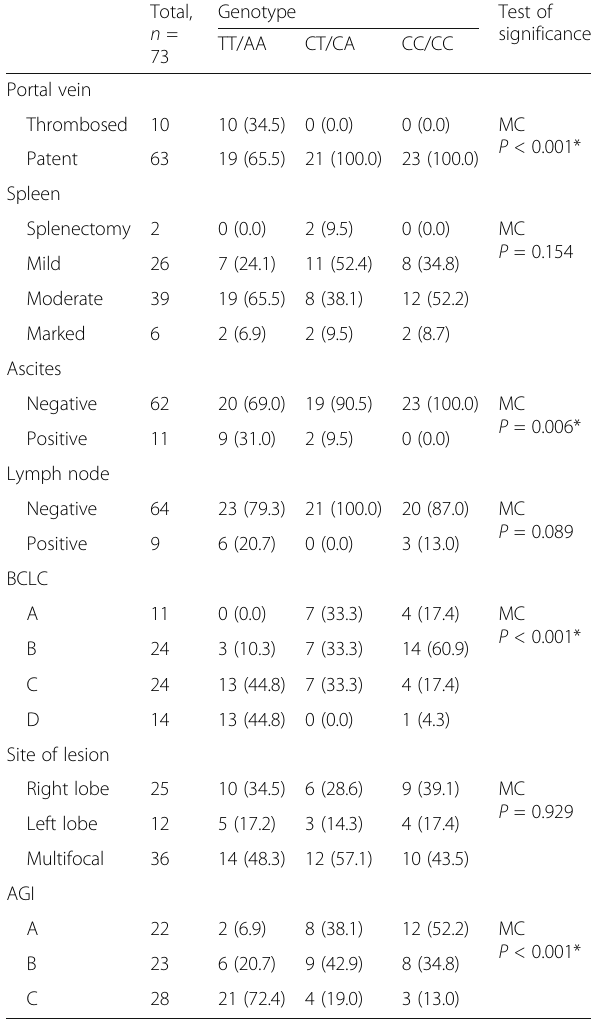
Table 4 Tumour characteristics of HCC cases according to IL-10